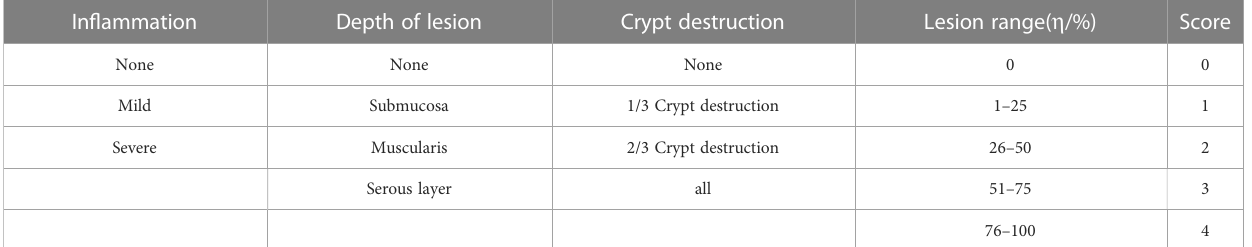
TABLE 4 Scoring criteria for histological injury of colonic tissue. In fl ammation